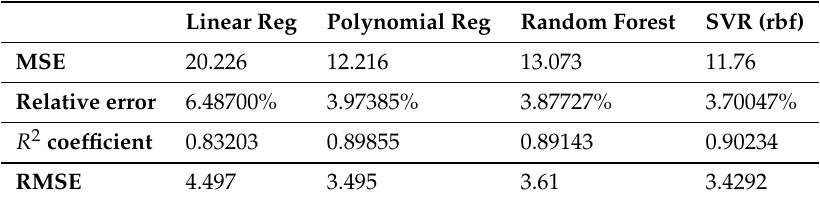
Table 7. Third experiment: evaluation coefficients for linear regression, polynomial regression, random forest and Support Vector machine with rbf